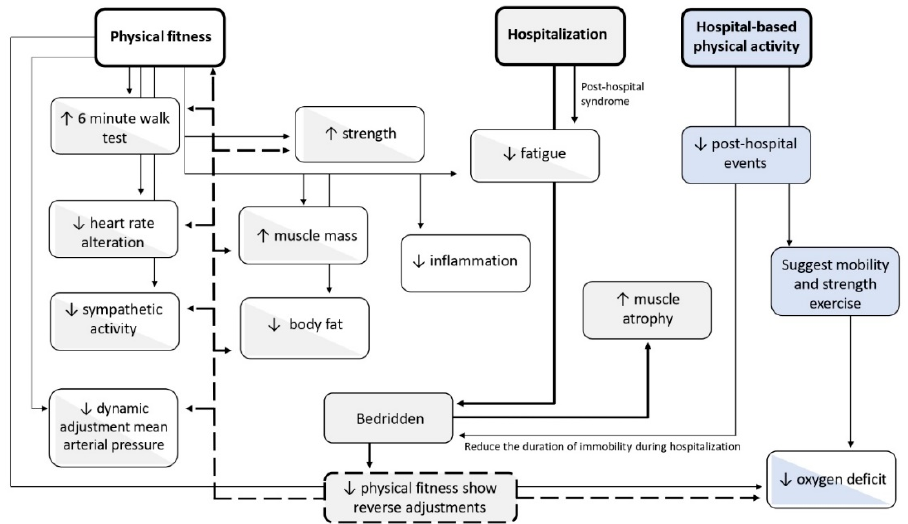
Figure 6. Physiological adaptations of exercise and reduced exercise in healthy adults (white boxes), hospitalized patients (grey boxes), and physical activity during hospitalization patients (blue boxes) and bicolor boxes show the reverse adjustments. Dotted lines: reverse, detrimental adjustments in physical fitness indicators due to hospitalization and/or long time bedridden/immobility. Continu- ous lines: adjustments during exercise (mild lines) and during hospitalization (bold lines).